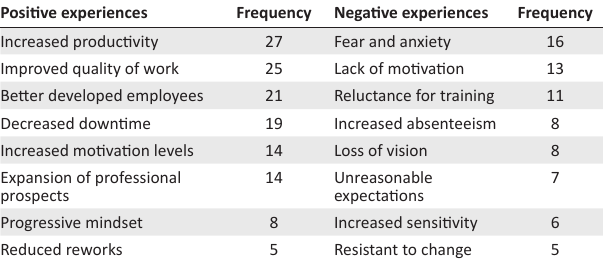
TABLE 6: Positive and negative experiences for employees with the introduction of robots. Positive experiences